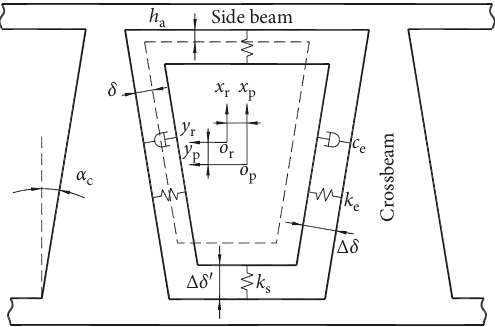
Figure 3: Interaction between the roller and